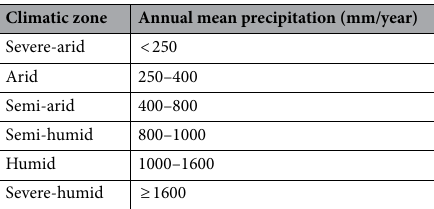
Table 1. The division of climatic zones using annual mean precipitation based on bias-corrected gauge